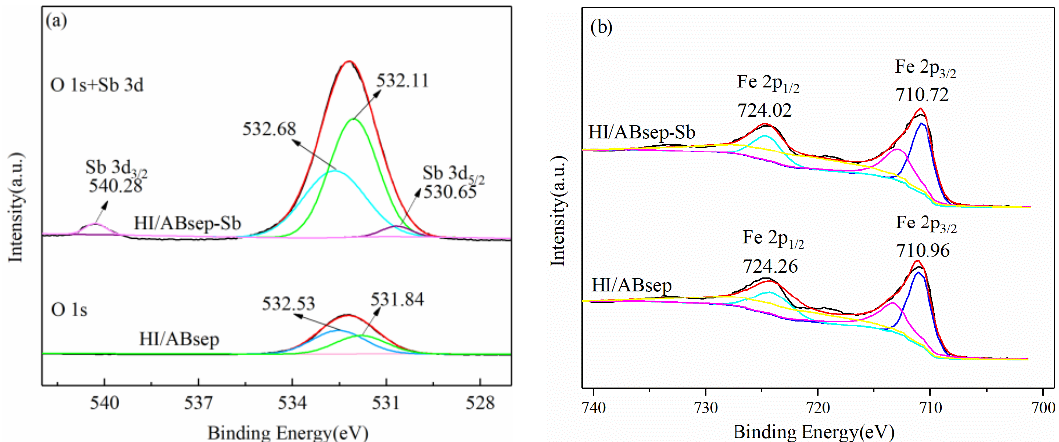
Figure 7. XPS spectra before and after HI/ABsep adsorption on Sb (III). ( a ) is the fine spectrum of O1s before and after the reaction, and ( b ) is the fine spectrum of Fe2p before and after the reaction). The red line in Figure 7a indicates the peak fitted to the data, indicating that it is composed of the peaks in the green, cyan, and purple lines; the green and cyan lines represent the two characteristic peaks of O1S corresponding to FeOOH and Si=O; and the purple line represents the characteristic peak of Sb (III); The XPS spectra before and after the adsorption of Sb (III) by HI/ABsep are shown in Figure 7b, respectively. The red line indicates the peak made by fitting the data, and the fuchsia line, cyan line and blue line are made by splitting the peak from the red line. The fuchsia line and the blue line indicate the two satellite peaks of the Fe2p3/2 orbit. The cyan line indicates the characteristic peak of Fe2p1/2 orbit.